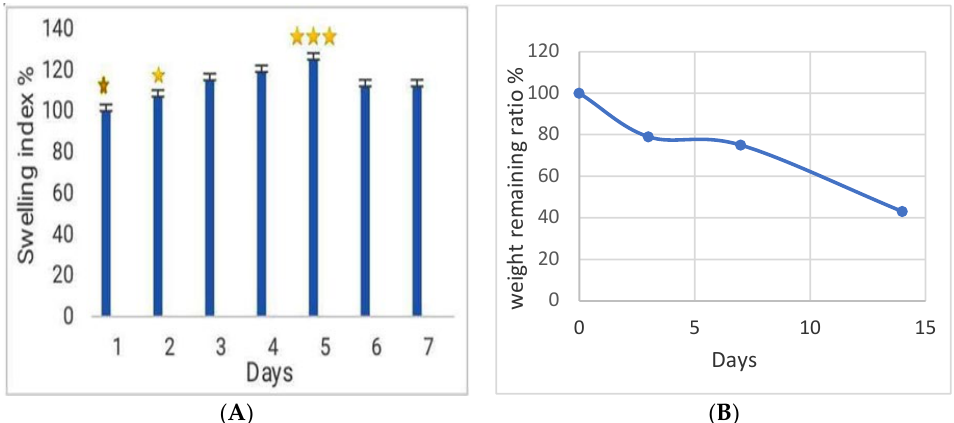
Figure 5. ( A ) The swelling index and ( B ) degradation of SA - CMC hydrogels. The results are based on three repeats showing the average with standard deviations. Based on the analysis of Figure 5A , hydrogel swelling on day 5 is significant with the rest of the days ( p < 0 .001) and the day 1 is significant with the rest of the days , except for day 2 , at the level of p < 0.05. Moreover, day 2 is significant with day 4 ( p < 0.05).